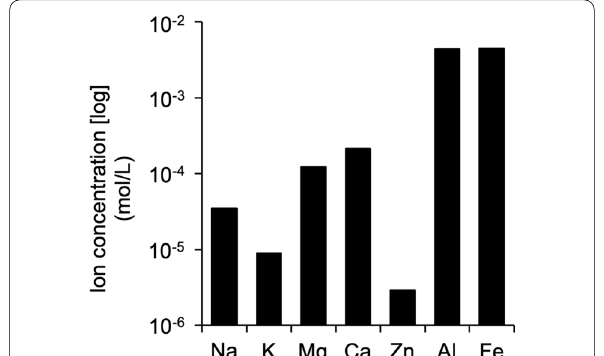
Fig. 1 Ion concentration of SE. Mineral concentration was analyzed by inductively coupled plasma/mass spectrometry (ICP/MS). Data are expressed as independent experiments. Values were averages of two measurements of the